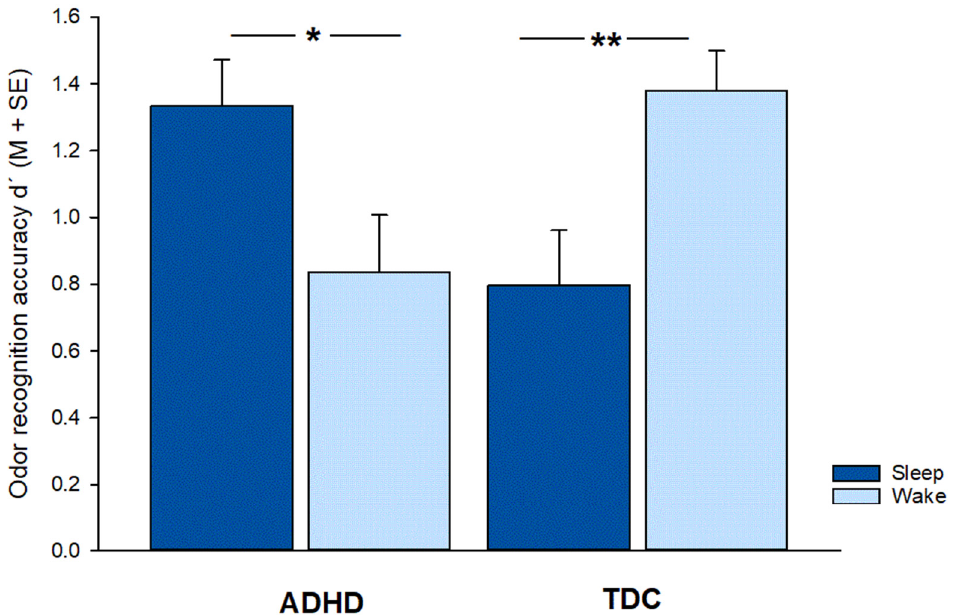
Figure 1. Odor recognition accuracy (d’) of the ADHD (attention deficit hyperactivity disorder; left) and TDC (typically developing children; right) sleep (dark blue) and wake groups (light blue); in ADHD odor recognition accuracy was higher in the sleep group compared to wake group, in TDC this pattern was reversed; M, mean; SE, standard error of means,*, p < 0.05; **, p < 0.01.